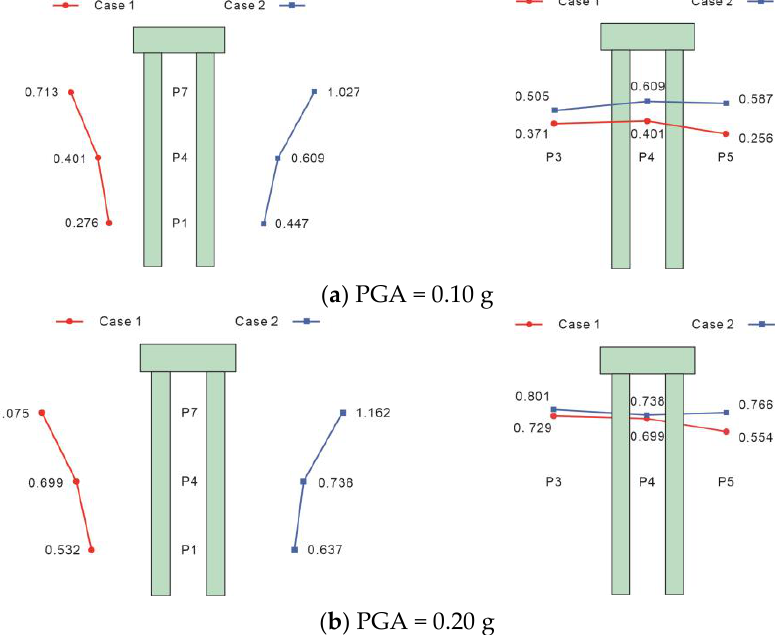
Figure 7. Distribution of the peak excess pore water pressure ratio along the vertical and horizontal directions.